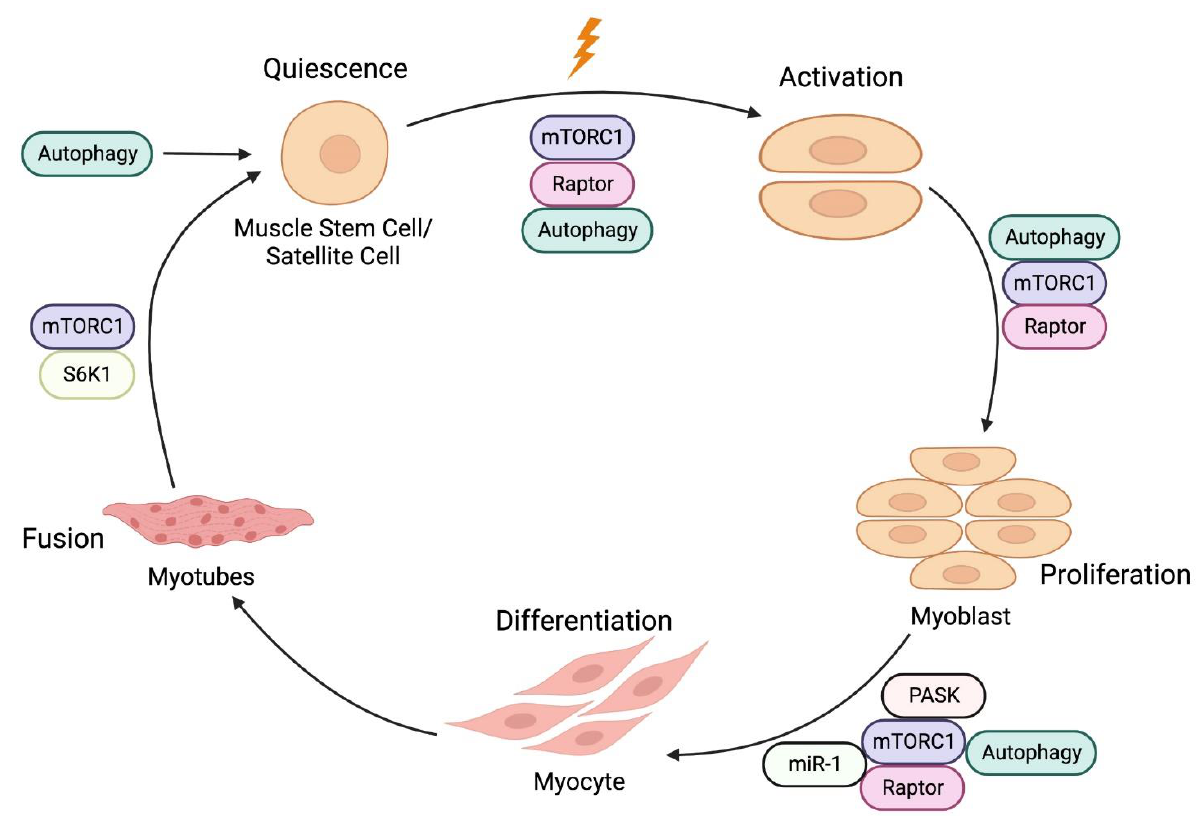
Figure 4. A schematic representation of muscle regeneration. Muscle stem cells (MuSCs) activation, proliferation, differentiation into myoblasts and fusion of myoblasts to form myofibers are under the regulation of mTORC1 signaling and autophagy.